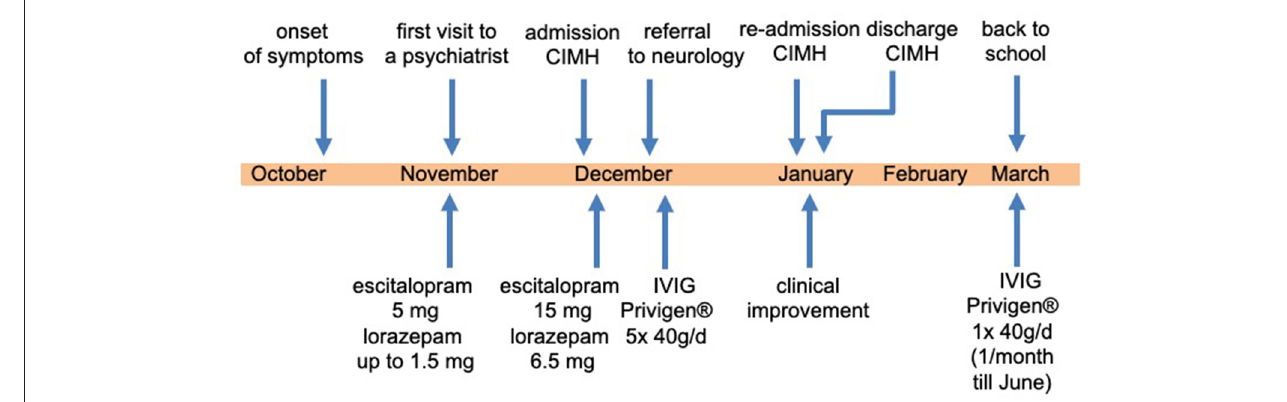
FIGURE 1 | Relevant data from this episode of care organized as a